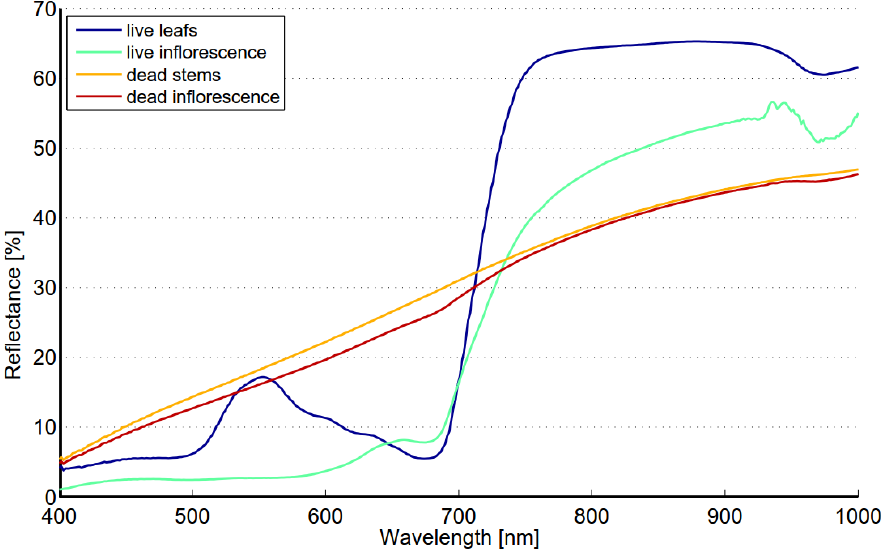
Figure 9. The partial spectra of reed bed.